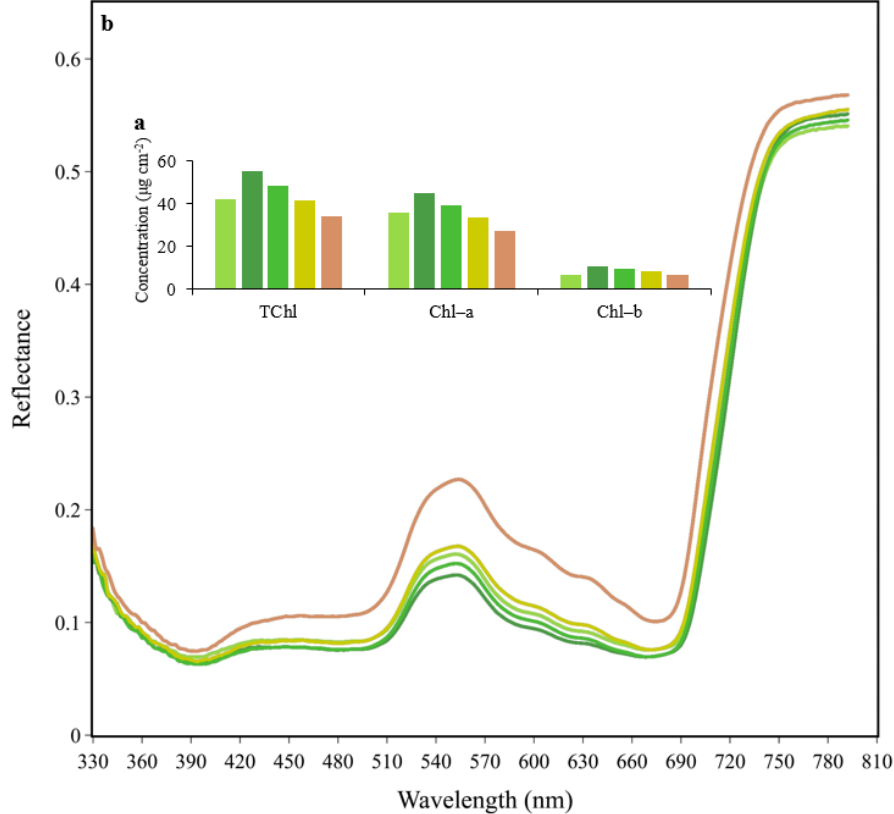
Figure 2. Chlorophyll concentrations and flag leaf reflectance spectra of randomly selected leaf samples in five dates throughout the season (one leaf per date). Barplot of varying concentrations of total chlorophyll (TChl), chlorophyll a (Chl-a) and chlorophyll b (Chl-b) ( a ). Corresponding reflectance spectra of each sample chlorophyll concentration ( b ). Colors represents chlorophyll concentrations and their respective reflectance spectrum.